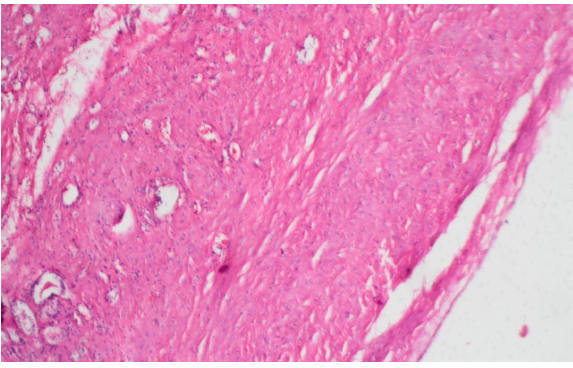
Figure 3. Pathological examination of a renal